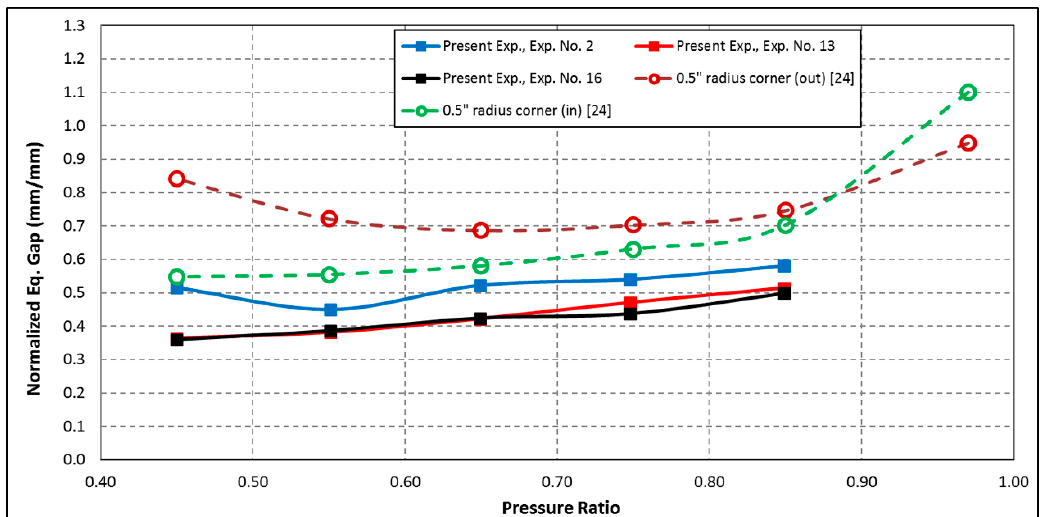
Figure 13. Normalized equivalent gap data (baseline condition).